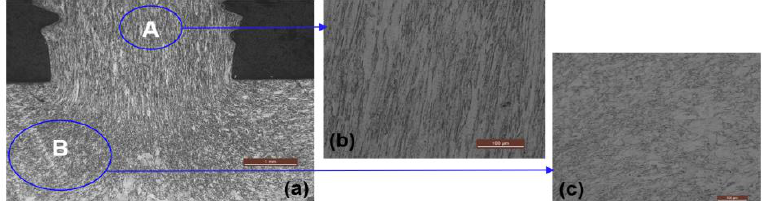
Figure 19: (a) Cross-sectional optical micrograph of the diode stud portion in etched condition, etchant: acidified potassium dichromate, (b) magnified view of the encircled regions in Figure 19a.